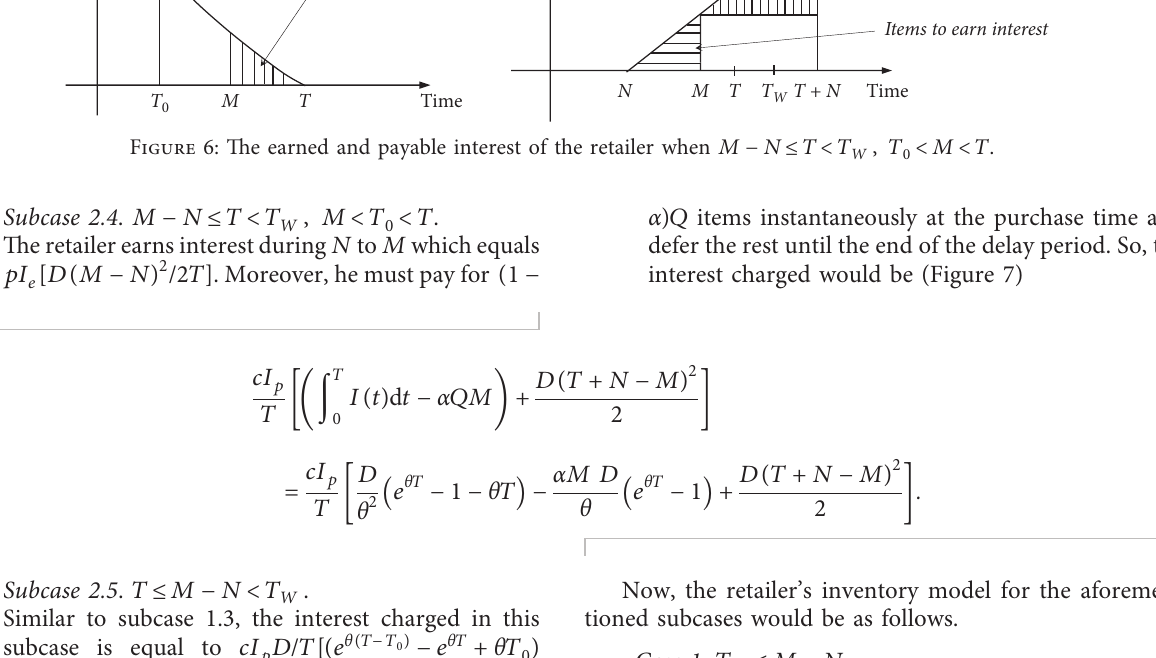
Figure 5: The earned and payable interest of the retailer when M − N ≤ T < T